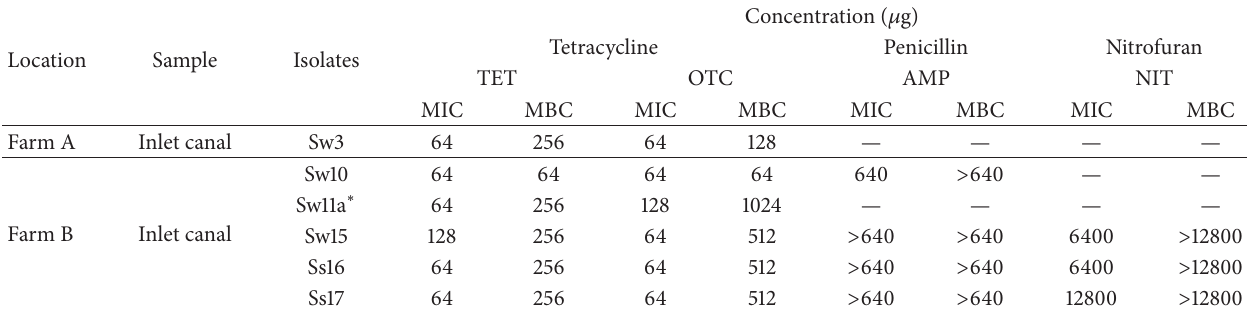
Table 2: Minimum inhibitory (MIC) and bactericidal (MBC) concentrations of antibiotics tested against resistant Salmonella spp. strains isolated from water and sediment samples of ponds and inlet canal (Jaguaribe River) in two freshwater-acclimated Litopenaeus vannamei culture farms (A and B), Ceara,